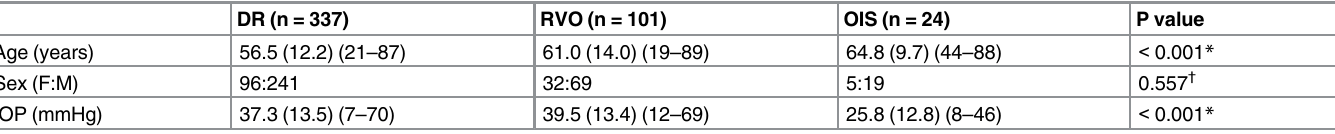
Table 2. Comparison of the clinical characteristics among the eyes with rubeosis iridis associated with diabetic retinopathy (DR), retinal vein occlusion (RVO), and ocular ischemic syndrome (OIS; mean [standard deviation] and range for age and intraocular pressure [IOP], the number of eyes for sex distribution).